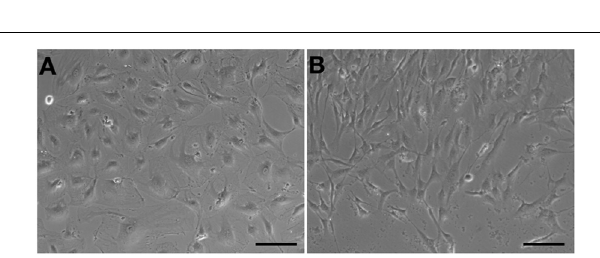
FIGURE 4 | cAVM-ECs trans-differentiated into mesenchyme-like cells in a short period. (A) HA-ECs kept the general morphology of ECs when passaged to 7th–8th population without morphological change; (B) The morphology of cultured cAVM-ECs changed into spindle-like cells after passaged to the forth